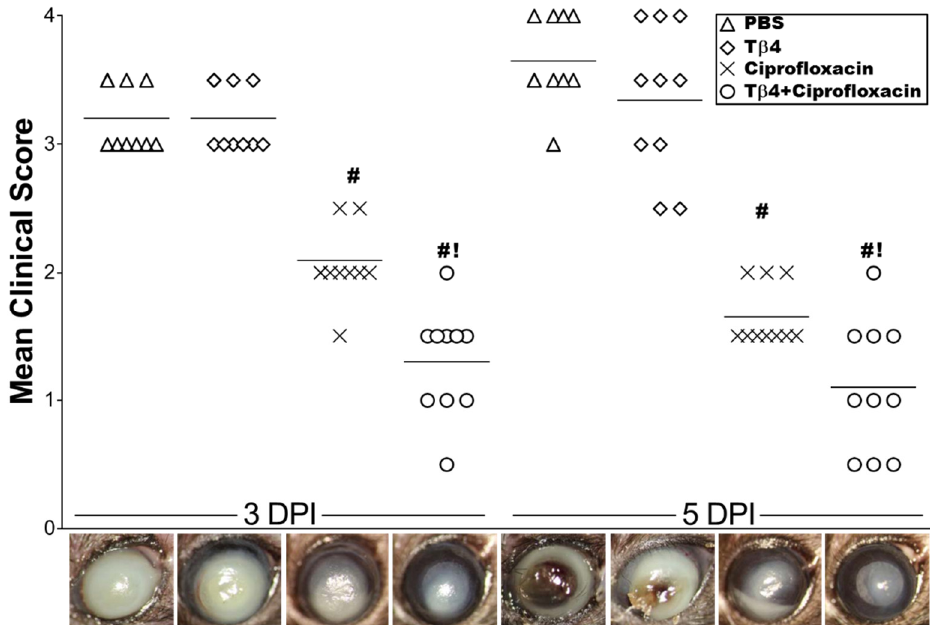
Figure 1. Ocular disease response of P. aeruginosa -infected B6 mice. Corneal response was graded at 3 & 5 days p.i. ( N = 10 mice/group). Results are represented as mean clinical scores ± SEM. Photographs taken by slit-lamp provide further visualization of the differences in clinical scores between the different treatment groups and include: PBS ( ∆ ), T β 4 ( ♦ ), ciprofloxacin ( × ), and T β 4 + ciprofloxacin (